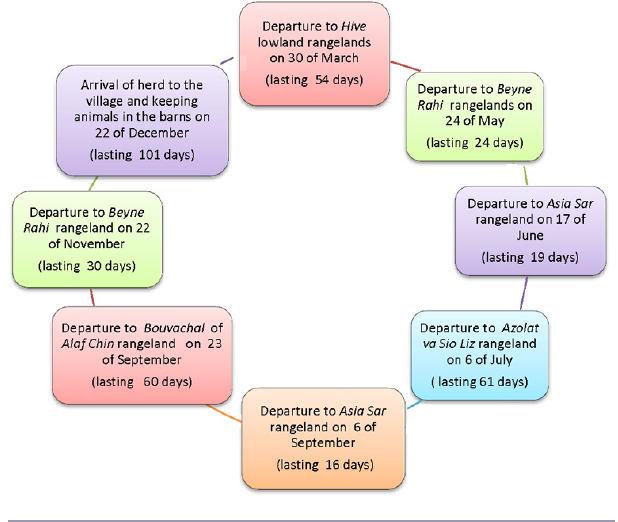
Fig. 5 . Herd management in the rangelands during 2011: herd no.